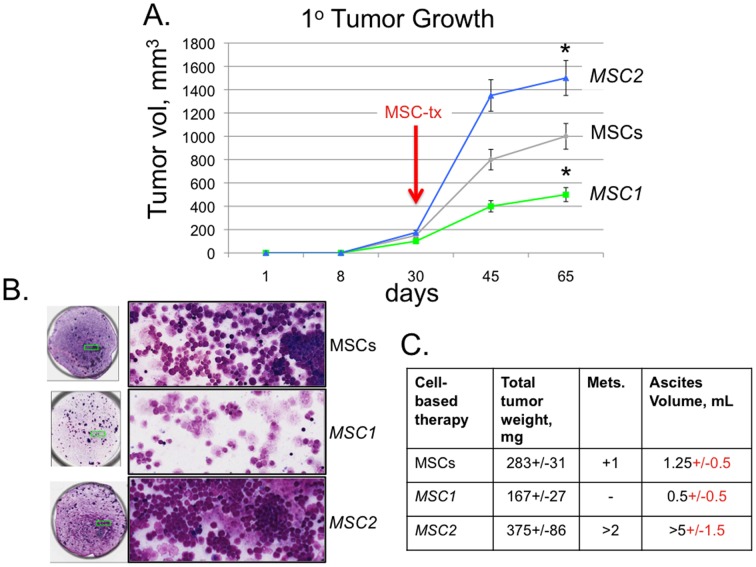

MSC1 do not support tumor growth whereas MSC2 favor tumor growth and metastasis.The established syngeneic mouse model for epithelial ovarian cancer used is based upon a spontaneously transformed mouse ovarian surface epithelial cell (MOSEC) line ID8 that has been previously described [21]. At approximately 4 weeks a single dose of human MSCs (MSCs), MSC1, or MSC2 (1×106/per mouse) were injected intraperitonealy (IP) as indicated by red arrow. A. Tumor growth was measured at weekly intervals until day of mouse sacrifice (Day 65). Harvested tumors and metastasis were weighed, counted and processed for flow cytometry and immunohistochemical analysis (IHC). *P<0.05 versus the MSCs-treated tumors. B. Accumulated ascites was collected, measured, and a sample was spun on cytospin slides and stained by DiffQuick cytology stain by standard methods. Left circles are representative micrographs of cytospin slides (20X) with enlarged areas to the right marked by green box (100X). C. Table of average +/−SEM results among the different MSC-treatment groups. Data are representative of three independent experiments with at least 6 mice per treatment group.